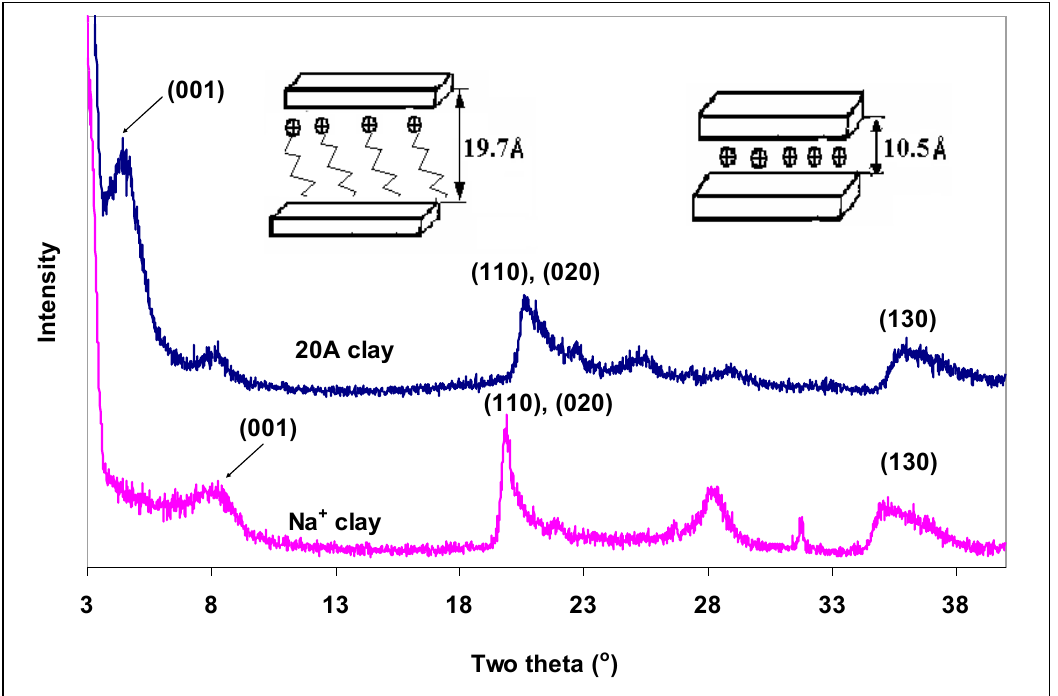
Figure 6. WAXD diffractograms for sodium clay and Cloisite 20A clay.